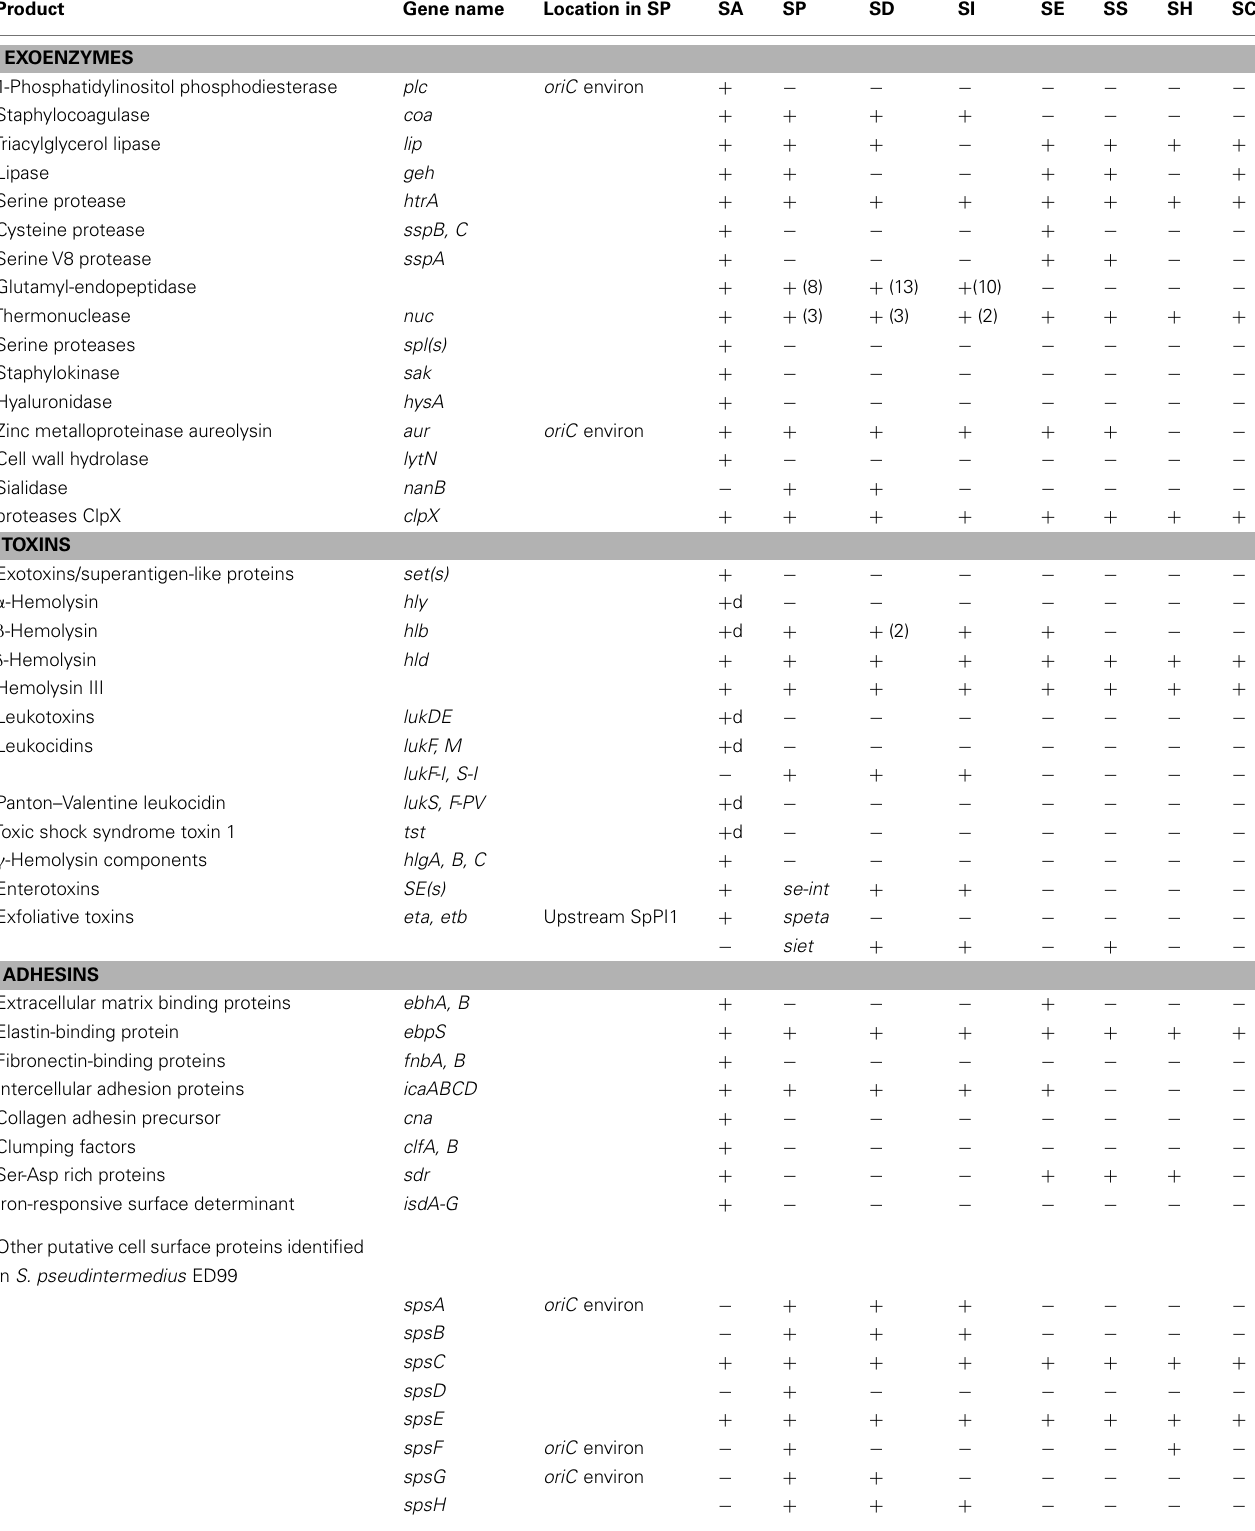
Table 2 | Distribution of virulence factors identified in eight staphylococcal